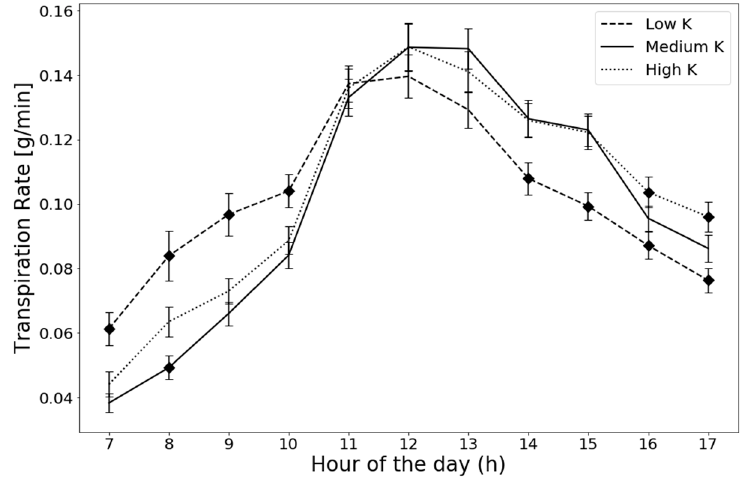
Figure 6. Mean transpiration rates calculated by PlantArray 15 minutes prior and after every round hour (image acquisition) across all 13 days of the experiment. The transpiration rates follow a daily pattern, reaching maximum transpiration rates at noon. Groups were compared using Friedman test followed by the Wilcoxon signed rank test. Significant differences were calculated at 7:00, 9:00–10:00 and 14:00–15:00 between the low treatment and other treatment groups (marked as a black diamond), at 8:00 between low and medium treatment groups and at 16:00–17:00 between low and high treatment groups.